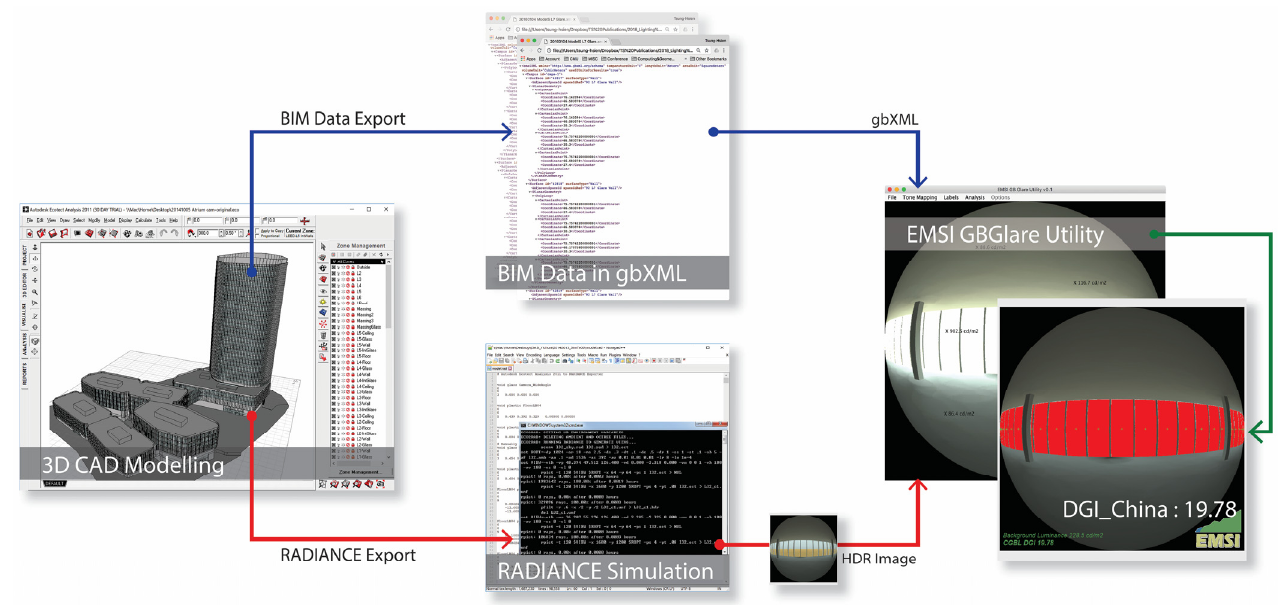
Figure 2. The stand-alone GBGlare Utility tool for calculating DGI China using a HDR image with the associated building information model.